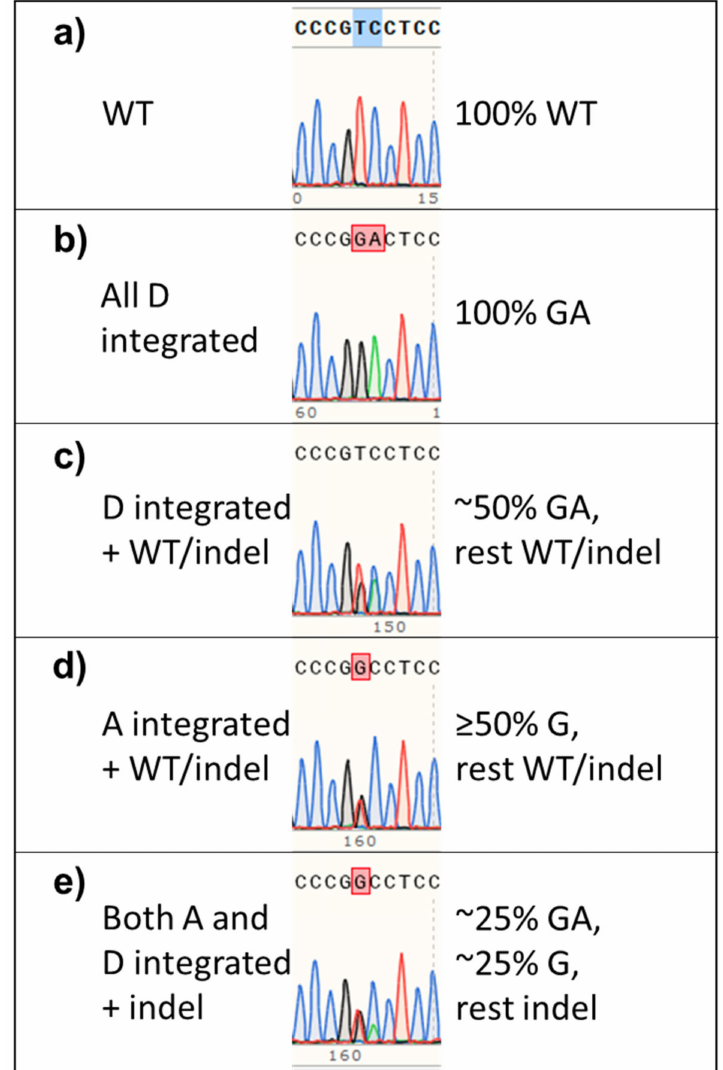
Figure 7. Sanger sequences of blastocysts integrating two di ff erent mutations into the same position on homologous / sister chromosomes. In most cases where two donors were simultaneously injected, either the D donor’s sequence or the A donor’s sequence was integrated. The WT sequence ( a ) was changed from TC to GA (two-point mutations, ( b , c )) to produce the D amino acid and from T to G (one-point mutation, ( d )) to produce the A amino acid. The two peaks for the D mutation are of a similar height, regardless of whether all ( b ) or some ( c ) of the bases replace the WT sequence. In one case, the two peaks of the integrated point mutations were of clearly di ff erent heights and the WT peaks at the same position were inversely of di ff erent heights ( e ) implying that both donor sequences were integrated into the genomic DNA in the same blastocyst. The sequence for each blastocyst is shown above its chromatogram. The WT sequence is shown at the very